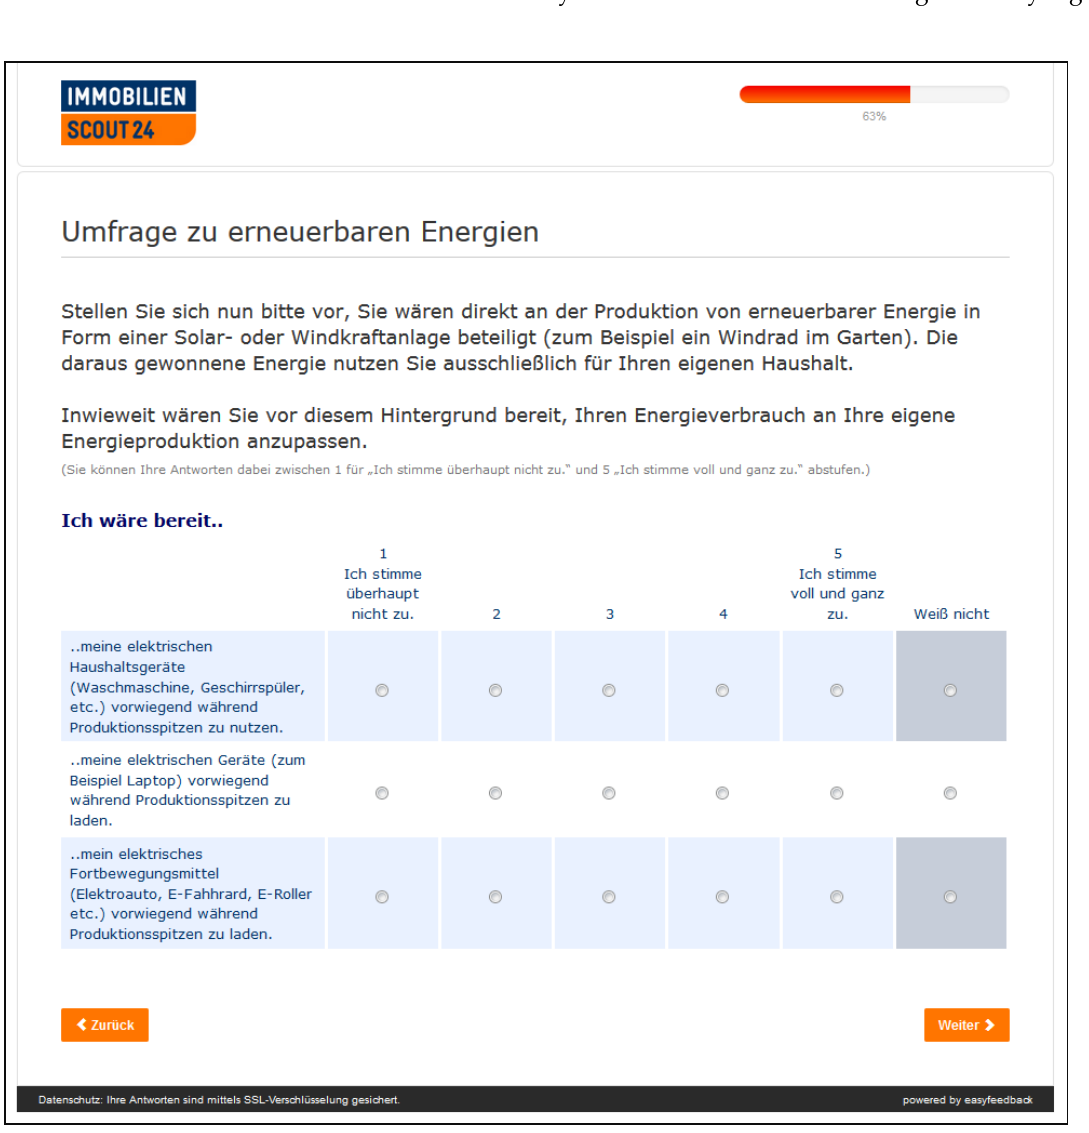
Figure A12. Screenshot of Questionnaire Page 11.